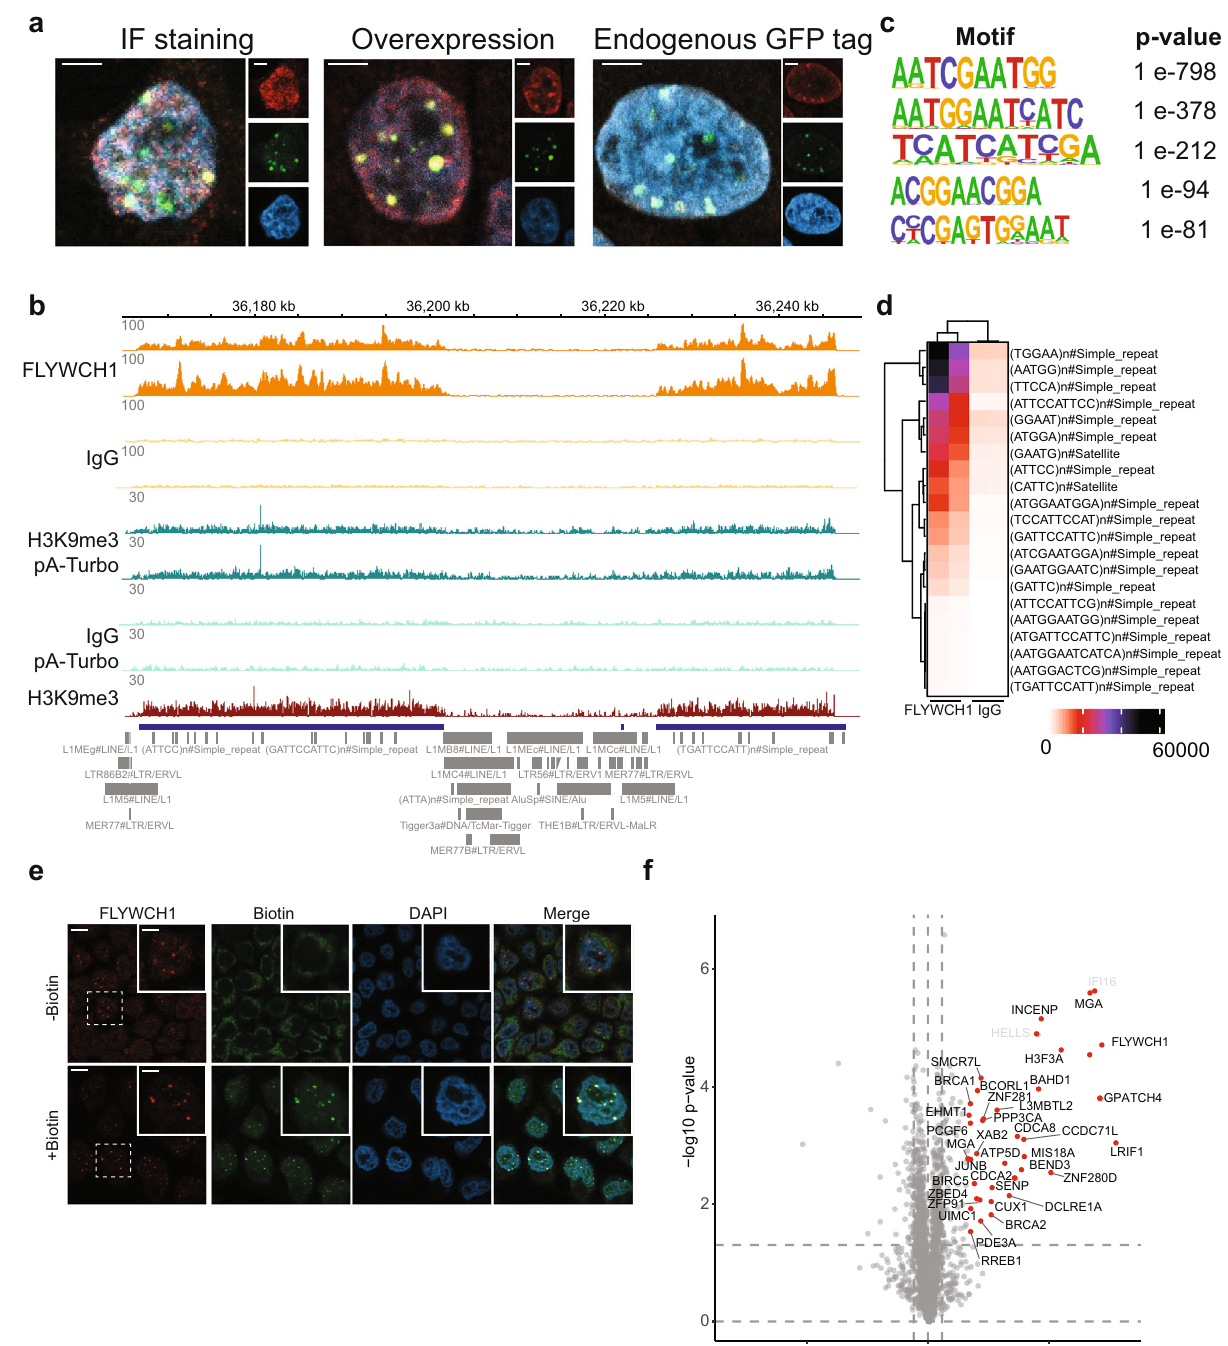
Fig. 3 ProtA-Turbo targeting of H3K9me3 reveals FLYWCH1 as a protein localized to (peri)centromeric heterochromatin. a Immuno fl uorescence of FLYWCH1 antibody staining (left), FLYWCH1-GFP overexpression (middle) or GFP-signal of FLYWCH1 endogenously tagged with GFP (right). The large panel is the merge, and the small panels are H3K9me3 (red), antibody/GFP signal (green), or DAPI (blue). Scale bars represent 3 µ m. b Representative screenshot of FLYWCH1-bound genomic regions as assessed by ChIP-seq. IgG was used as a control antibody. Gray markers indicate different repeat types from the Repeatmasker. c Most enriched DNA motifs under 451 FLYWCH1-speci fi c peaks. P -values were calculated using hypergeometric enrichment calculations using HOMER. d Intersection of FLYWCH1 ChIP-seq reads with most enriched repeat types/sequences that are at least 10-fold differential between FLYWCH1 and IgG ChIP-seq. e Immuno fl uorescence analyses of FLYWCH1 fused to miniTurboID. FLYWCH1 is visualized by staining the V5 tag (red). Scale bars represent 10 µ m in the large panels and 5 µ m in the zoomed panels. f Volcano plot of mass spectrometry analyses of biotin IPs of FLYWCH1-miniTurboID with biotin compared to wildtype HeLa cells incubated with biotin ( n = 3). Protein names in white indicate potential streptavidin contaminants (see also Source Data). Number of independent experiments performed: a 2; b 2; e 2; f 2, n = 3 replicates per independent experiment. Source data are provided as a Source Data fi